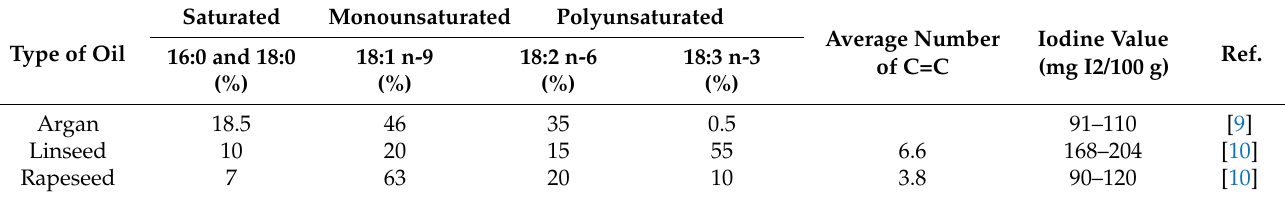
Table 1. Mean values of fatty acid composition in